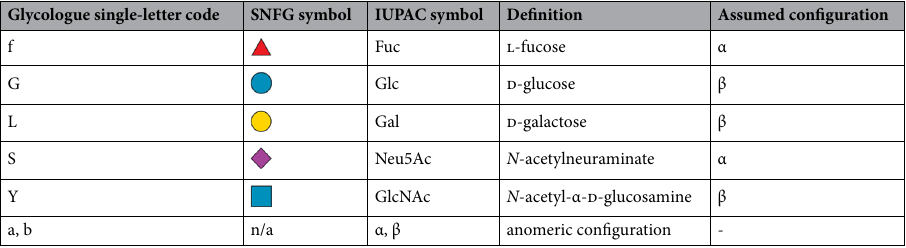
Table 1. Monosaccharide symbols. Definition of monosaccharide units of HMOs represented as single-letter codes in Glycologue, symbols in the Symbol Nomenclature For Glycans (SNFG) notation 58 , IUPAC symbols. For example, N -acetylgalactosamine (GalNAc) is represented by Glycologue as ‘V’, and sulfate by the lowercase